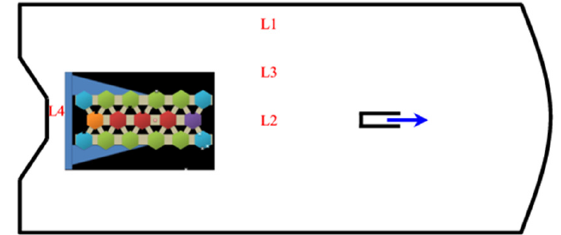
Figure 21. Sketch of the TIMO facility modeled in ProVac3D containing the NEG pump and showing the gas inlet position and direction.